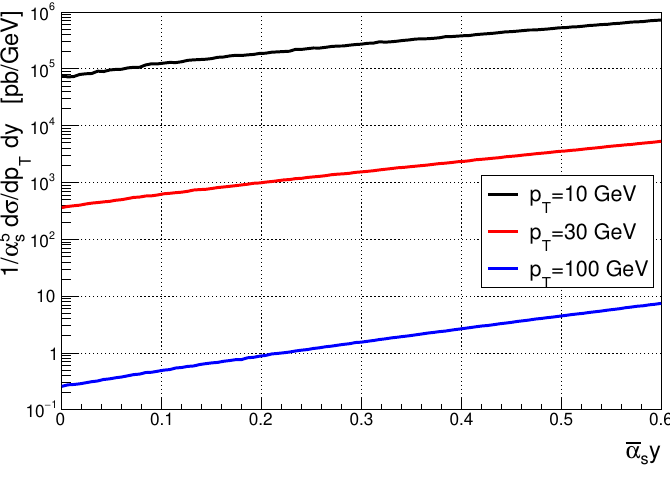
Figure 6 . Partonic cross section with the correlated Pomeron loop, eq. (3.4) as a function of rapidity for di(cid:11)erent values of transverse